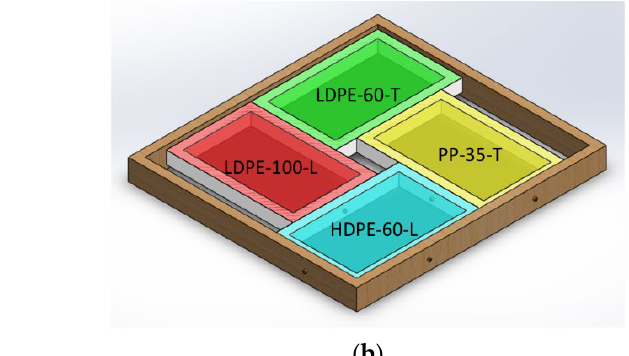
Figure 4. Thickness distribution for LDPE-100.